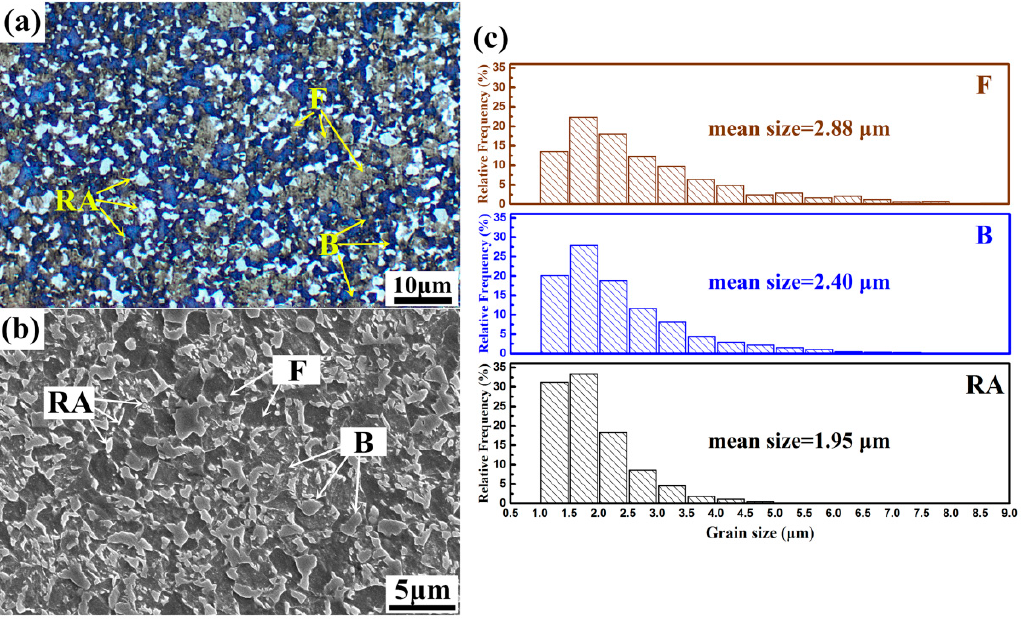
Figure 2. Micrographs of the heat treated specimen ( a ) color metallographic OM micrograph by LePera etching ( b ) SEM secondary electron image and ( c ) grain size statistics of different microstructure components by image analysis software based on color metallographic OM micrographs.